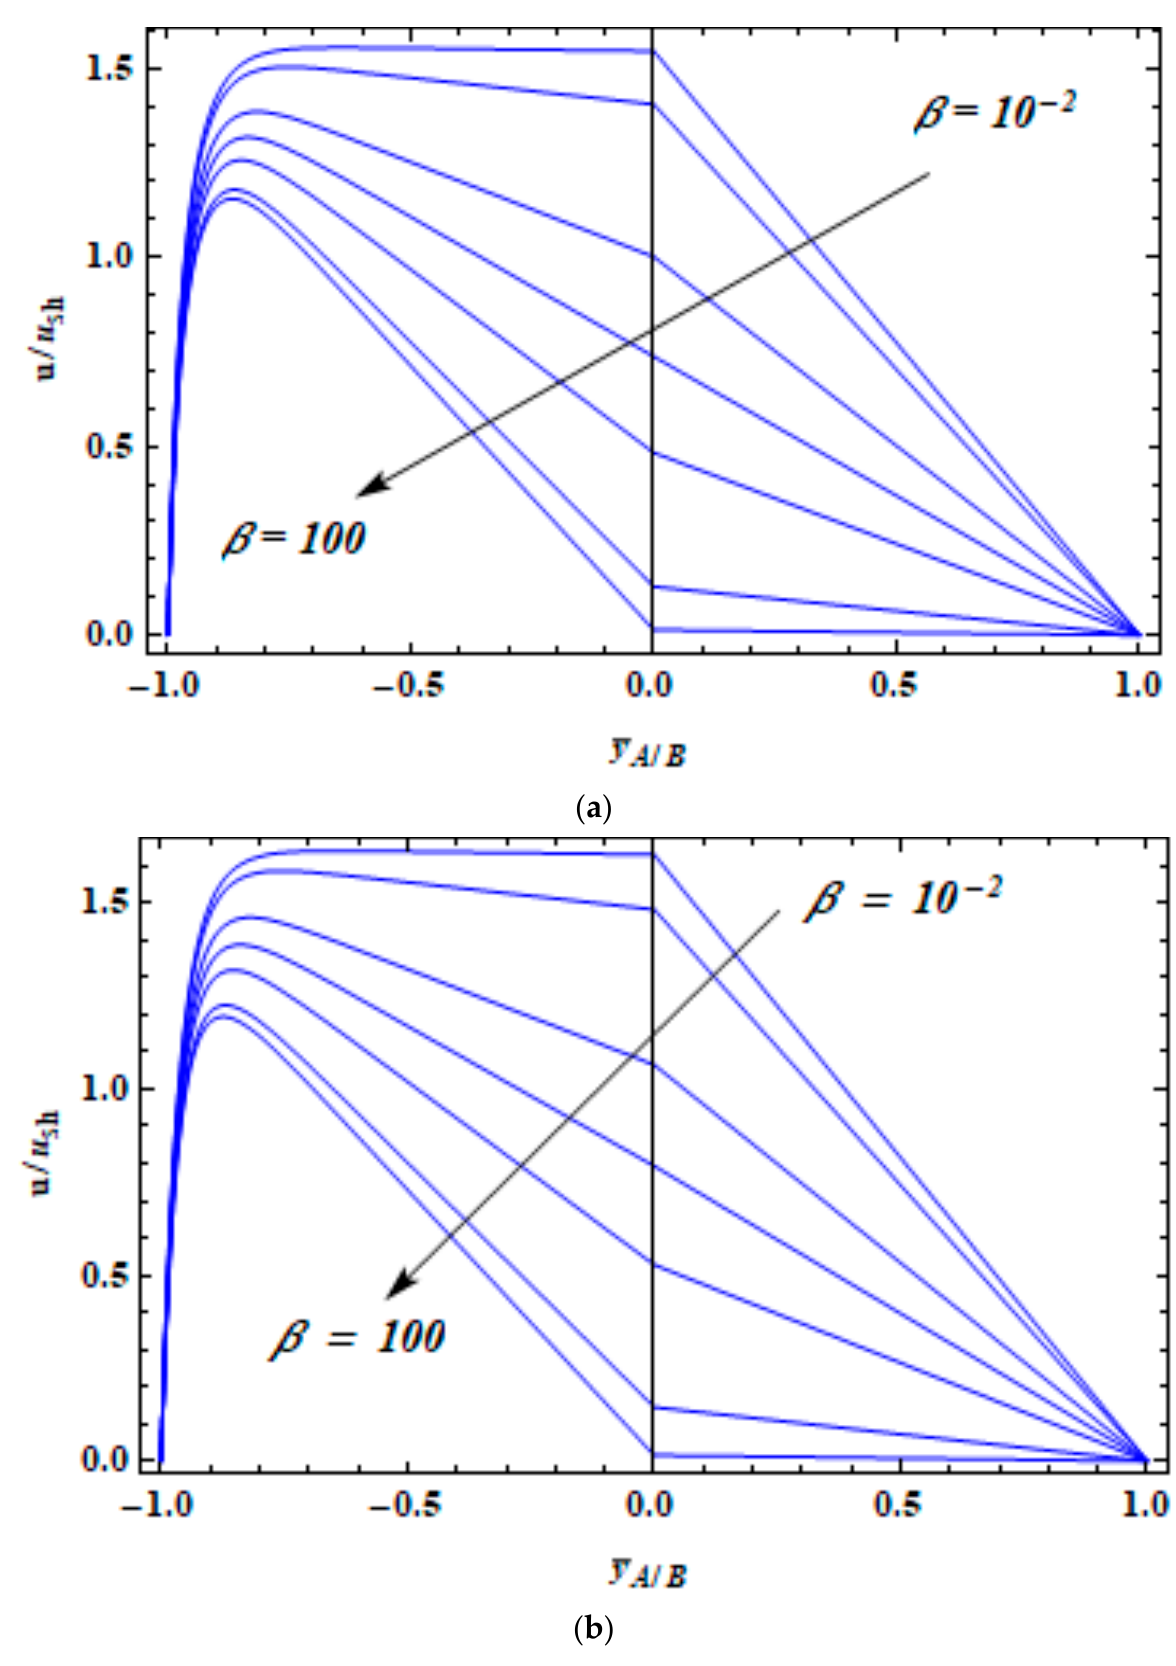
(cid:2869) = ; ( b ) 𝛽 = 1; 𝛤 = 0; 𝑅 = 20; 𝑅 (cid:3002) (cid:2870)